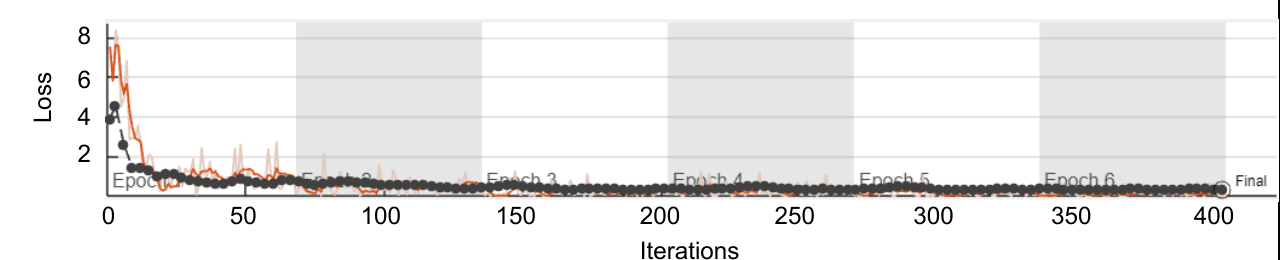
Figure 18. Loss versus iteration graph for Iris